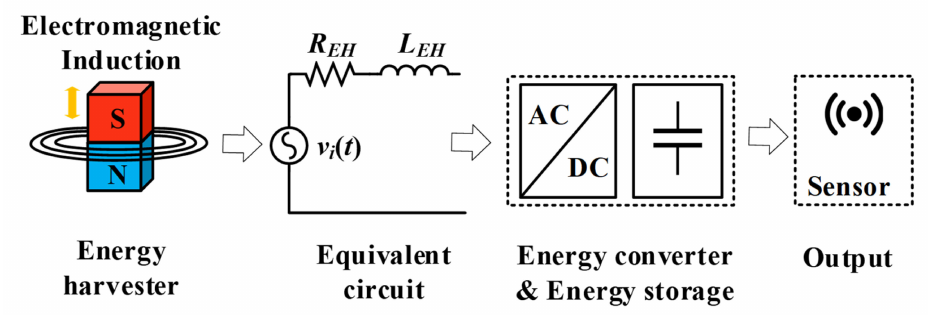
Figure 1. Basic architecture of electromagnetic EVEH.